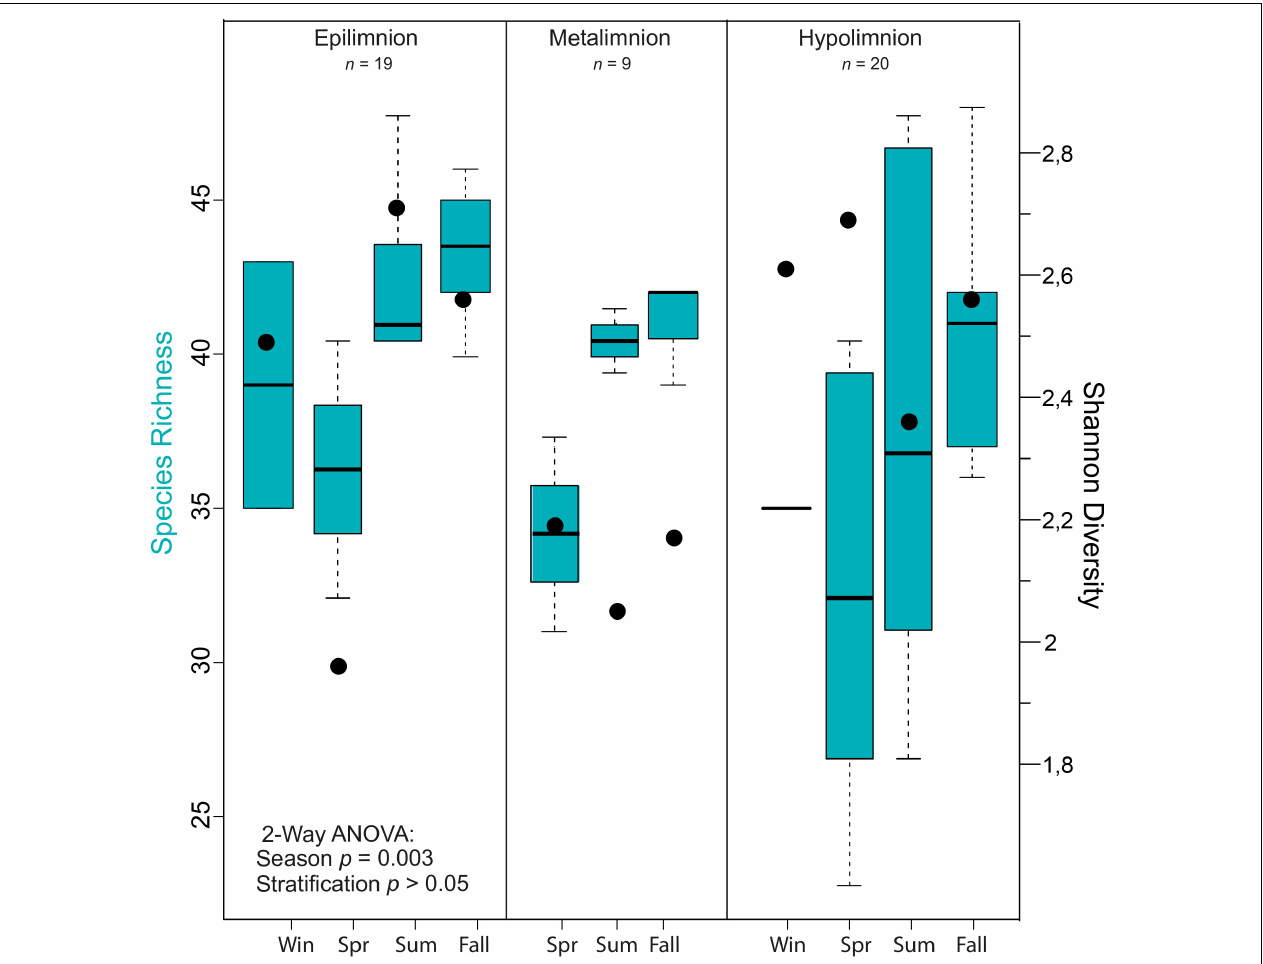
FIGURE 5 | Alpha diversity of cyanobacteria communities in Lake Tiefer See. Box plots showing the results of seasonal and stratification effects on cyanobacteria richness in Lake Tiefer See via a two-way analysis of variance (ANOVA) analysis and Shannon diversity indices shown by black dots. The ANOVA models’ assumptions were evaluated with Tukey’s honestly-significant-difference (TukeyHSD) post hoc tests.